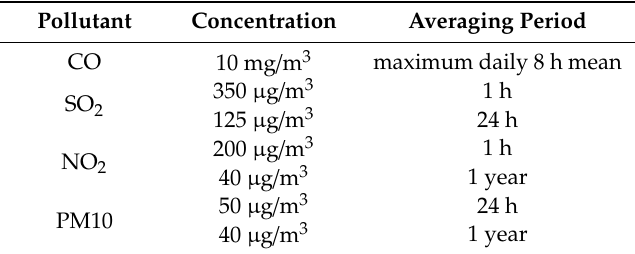
Table 6. Ambient concentration standards